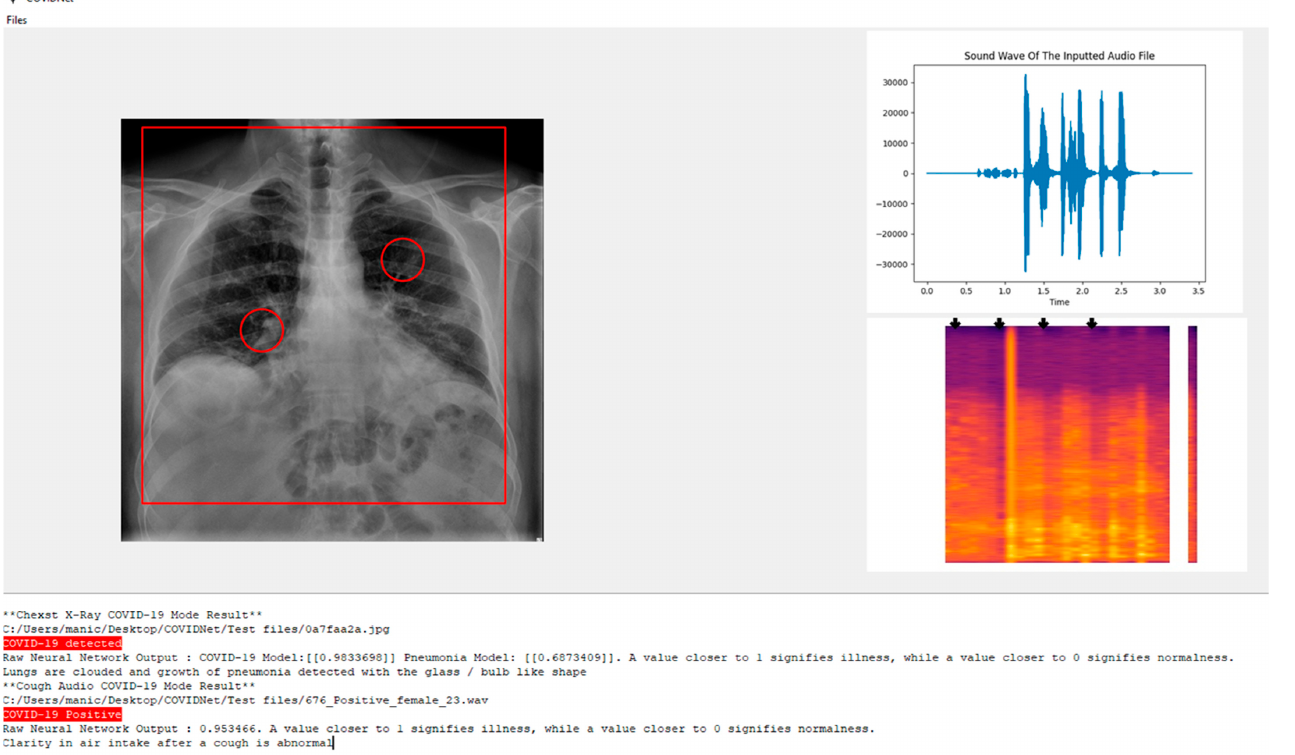
Figure 12. Diagnosing using CXR Image and Cough